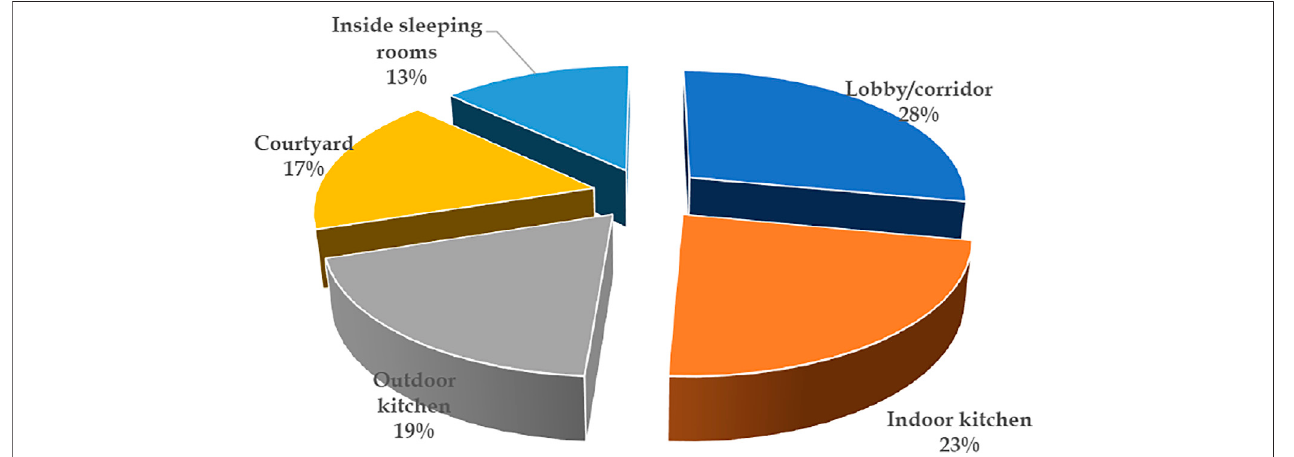
FIGURE 4 | Cooking spaces within houses in Keko Machungwa, Dar es Salaam. Source: Field work, 2020.